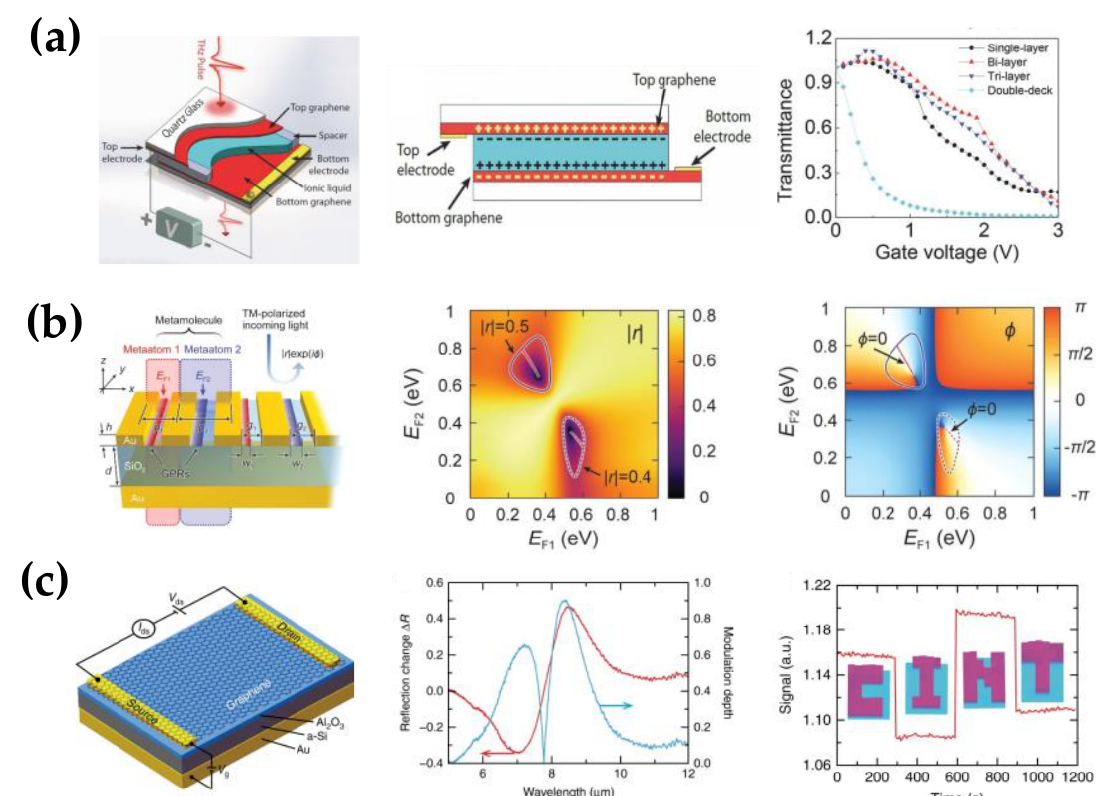
Figure 3. Electronically controlled terahertz amplitude modulator based on graphene. ( a ) Sandwich structure of two-layer graphene and ionic liquid, holes, and electrons accumulate at the ionic-liquid/graphene interfaces when a voltage is applied, the transmission modulation from structures with different numbers of the graphene layer; (Reprinted with permission from ref. [63]. Copyright 2015, Wiley-VCH) ( b ) Plasmonic metamolecule composed of independently controlled graphene meta-atoms, the graphene Fermi levels applied to meta-atoms are defined by E F1 and E F2 , a great amplitude modulation with the fixed phase of 0 ◦ and a 360 ◦ phase shift with the fixed amplitude of 0.5 can be realized by adjusting the E F1 and E F2 Reprinted with permission from ref. [67]. Copyright 2020, American Chemical Society; ( c ) Hybrid graphene metasurface for high-speed amplitude modulation where a-Si serves as part of the back gate electrode, the variation of reflection and modulation depth for V g = 7 V and − 3 V under different incident wavelengths, and spatial reflection patterns of “CINT” at λ = 8.3 µ m by selectively applying different gate voltages. (Reprinted with permission from ref. [66]. Copyright 2015, Nature Publishing